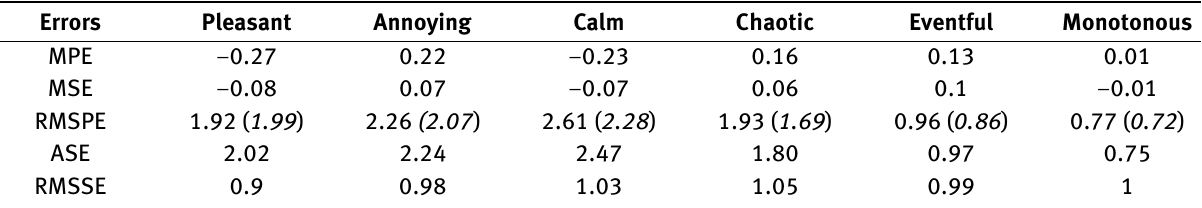
Table 4: Cross-validation process: analysis of all the error descriptors (mean values) and the standard deviation (SD) for all perceptual at- tributes